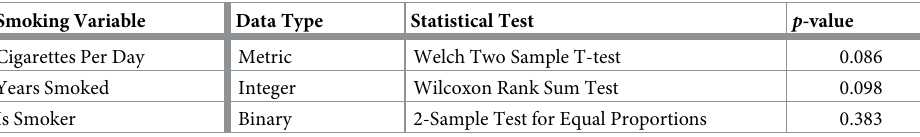
Table 2. Statistical test results comparing smoking variables to RAD51C-202